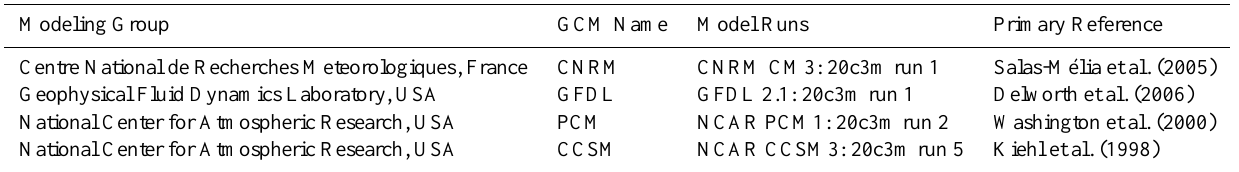
Table 1. GCM names and runs used in this study.